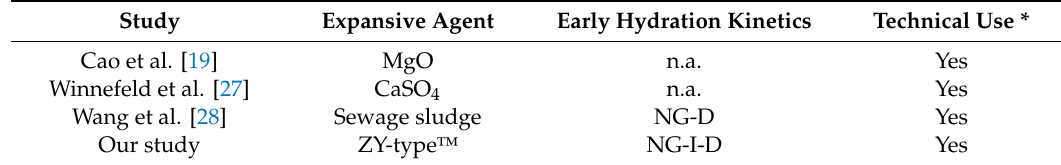
Table 5. Overview of early hydration kinetics of selected expansive cementitious binders.